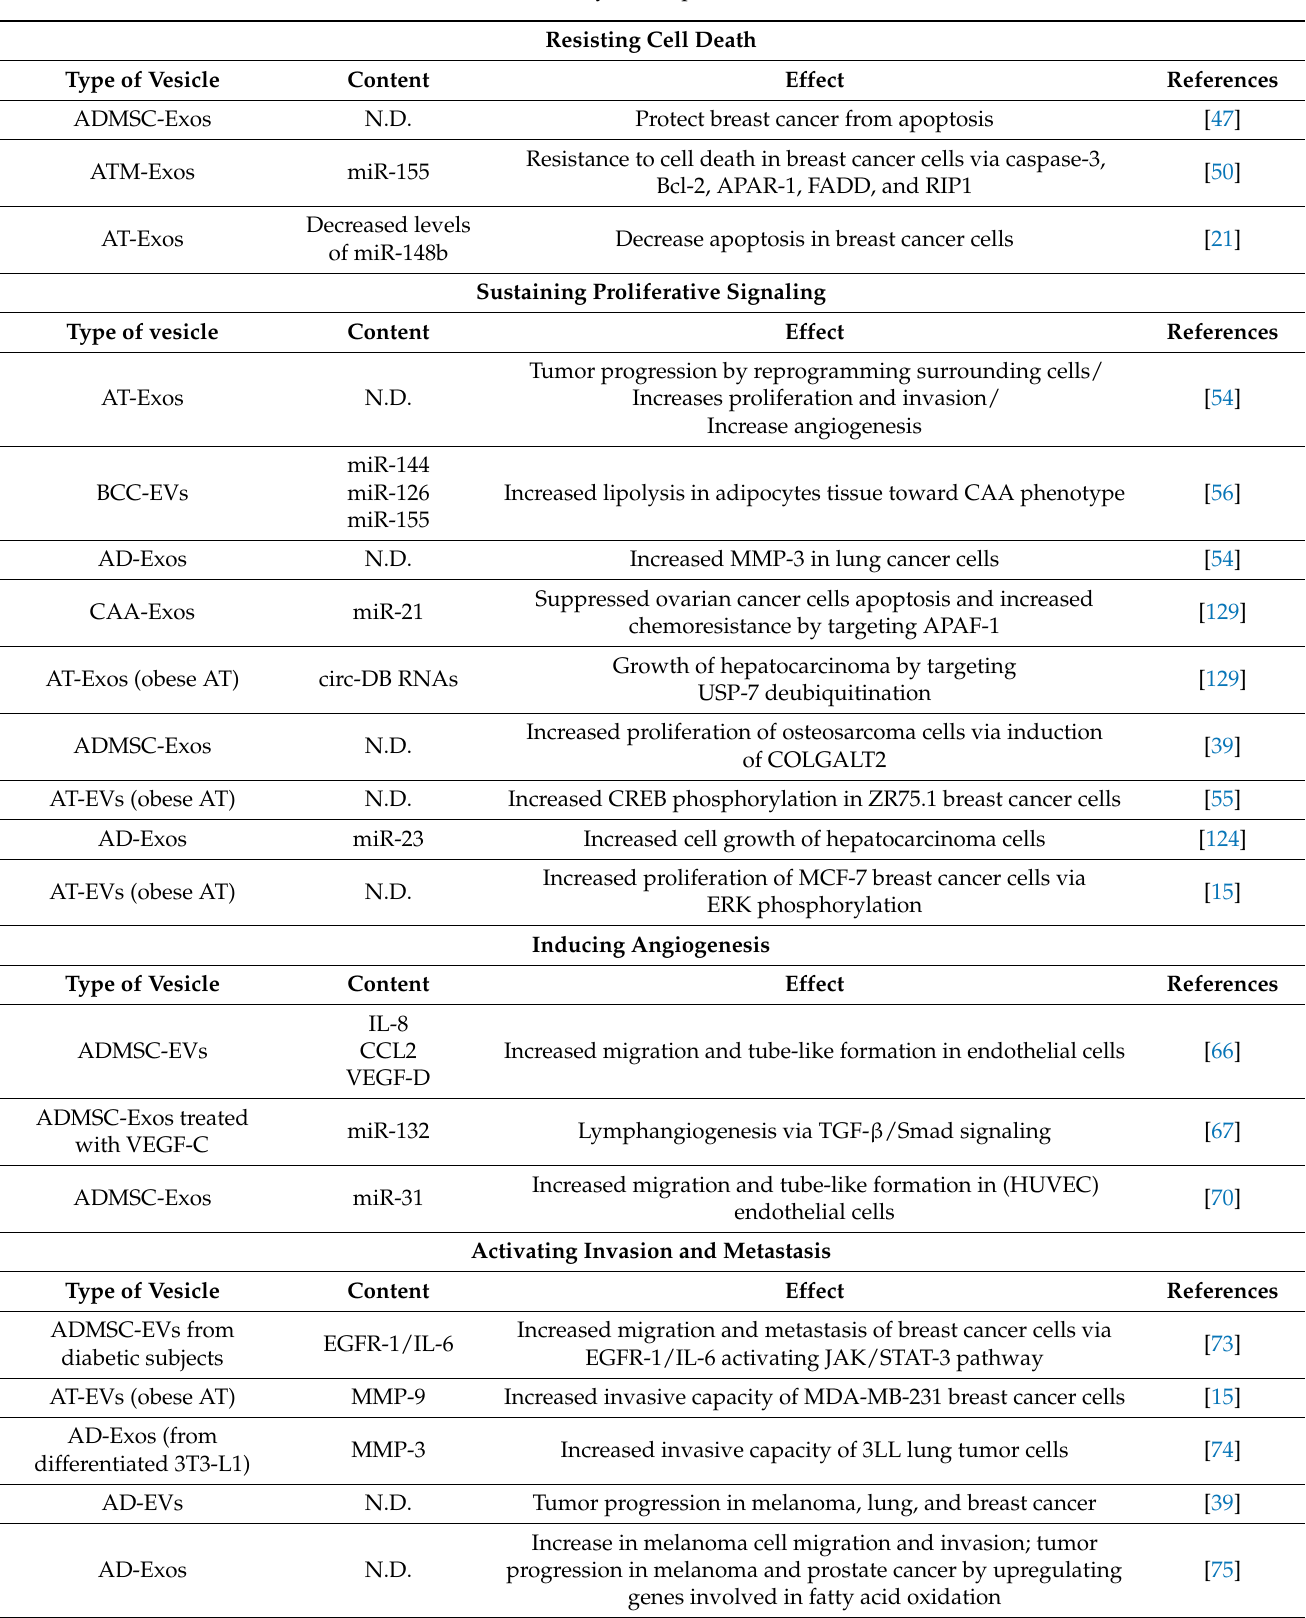
Table 1. Extracellular vesicles released by the adipose tissues and the modulated